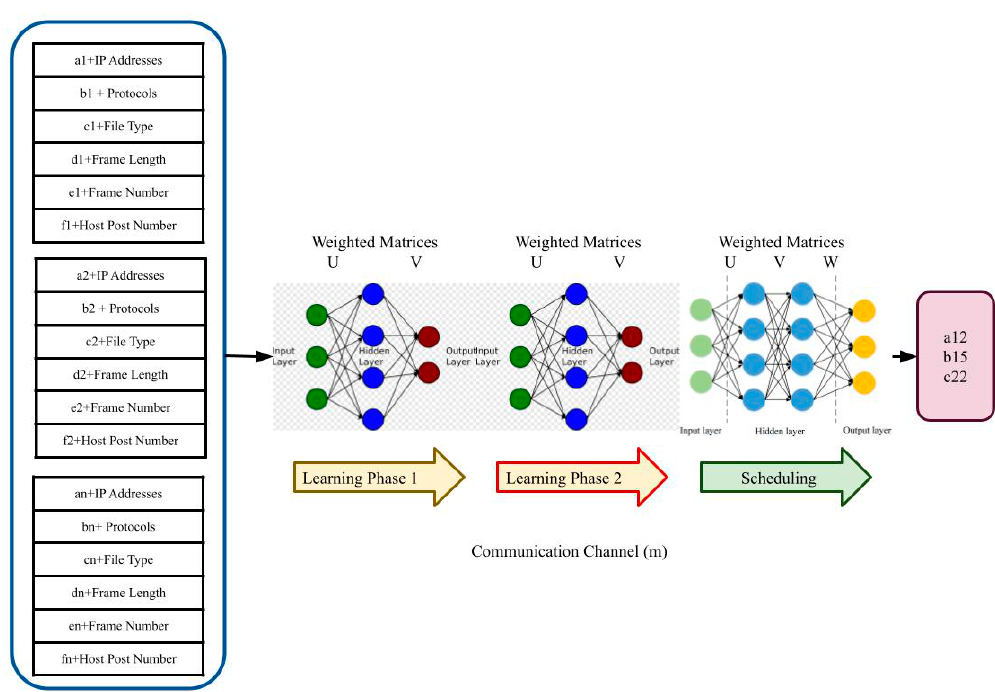
Figure 2. Data scheduling from patients using deep Q-learning.